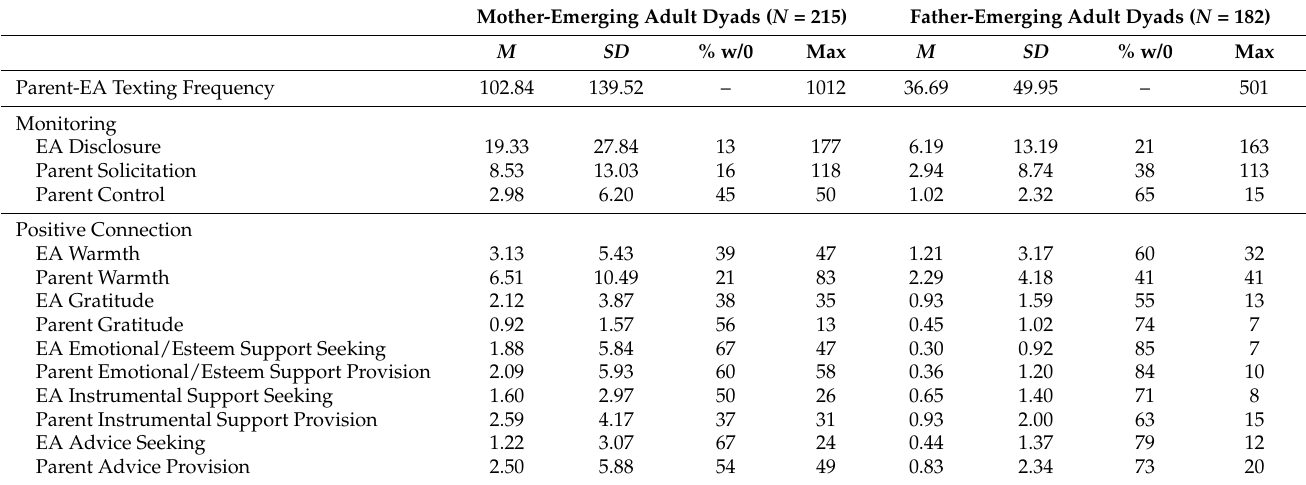
Table 3. Descriptive Statistics for coded PCTICS